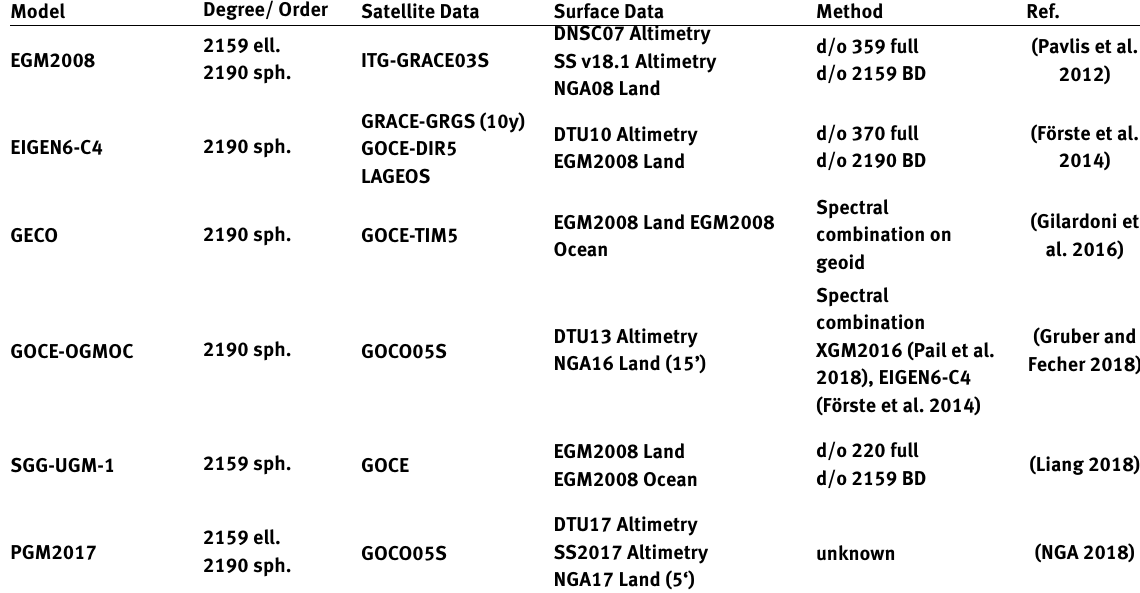
Table 2. Overview of GNSS-levelling datasets used for the study No. Region Points